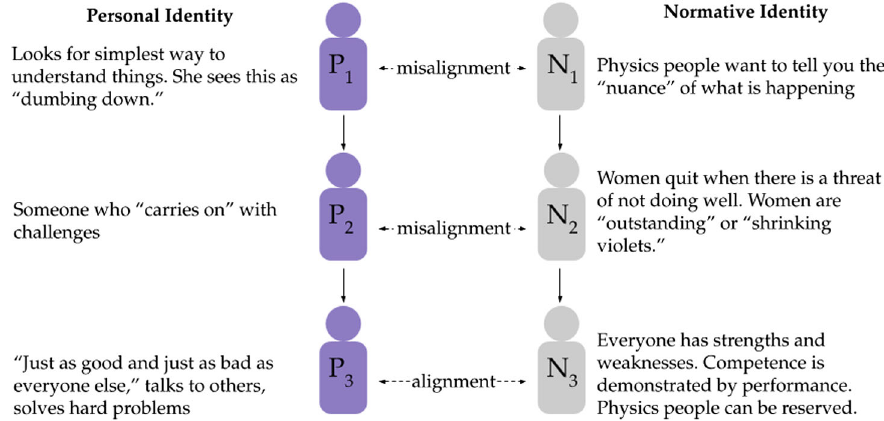
FIG. 3. Summary of Cassidy ’ s personal identity and perceived normative identity with respect to competence among peer